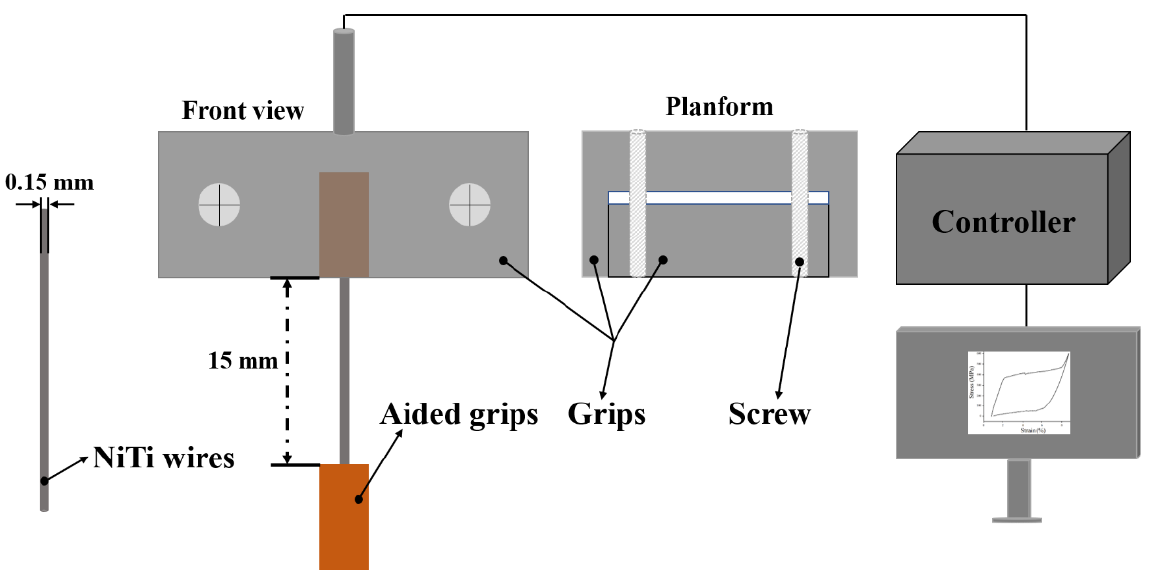
Figure 1. ( a – c ) show the bright-field TEM image, the SAED of the circled region in ( a ) and grain size distribution of the as-received NC NiTi sample, respectively.